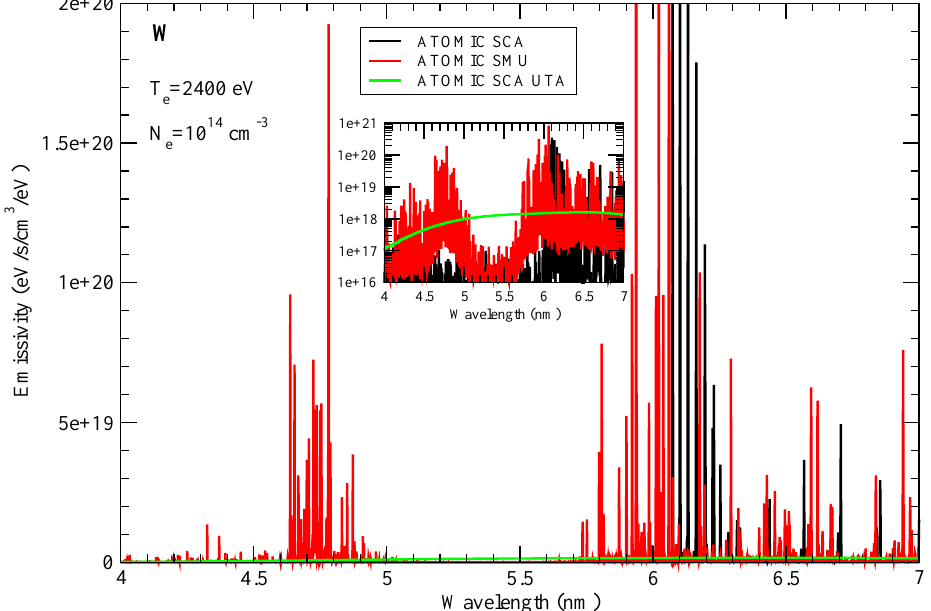
Figure 3. Emission spectrum of tungsten at a temperature of 2400 eV and an electron density of 10 14 cm − 3 . ATOMIC SCA calculations ( i.e. , semi-relativistic configuration-average calculation, black curve) are compared with ATOMIC SMU calculations ( i.e. , semi-relativistic calculations using MUTA-based fine-structure transitions, red curve). We also show an ATOMIC SCA UTA calculation (green curve) that uses UTA theory to broaden the bound-bound contribution to the spectrum. The inset figure shows the same set of spectra but on a logarithmic y-axis to more clearly show the ATOMIC SCA UTA